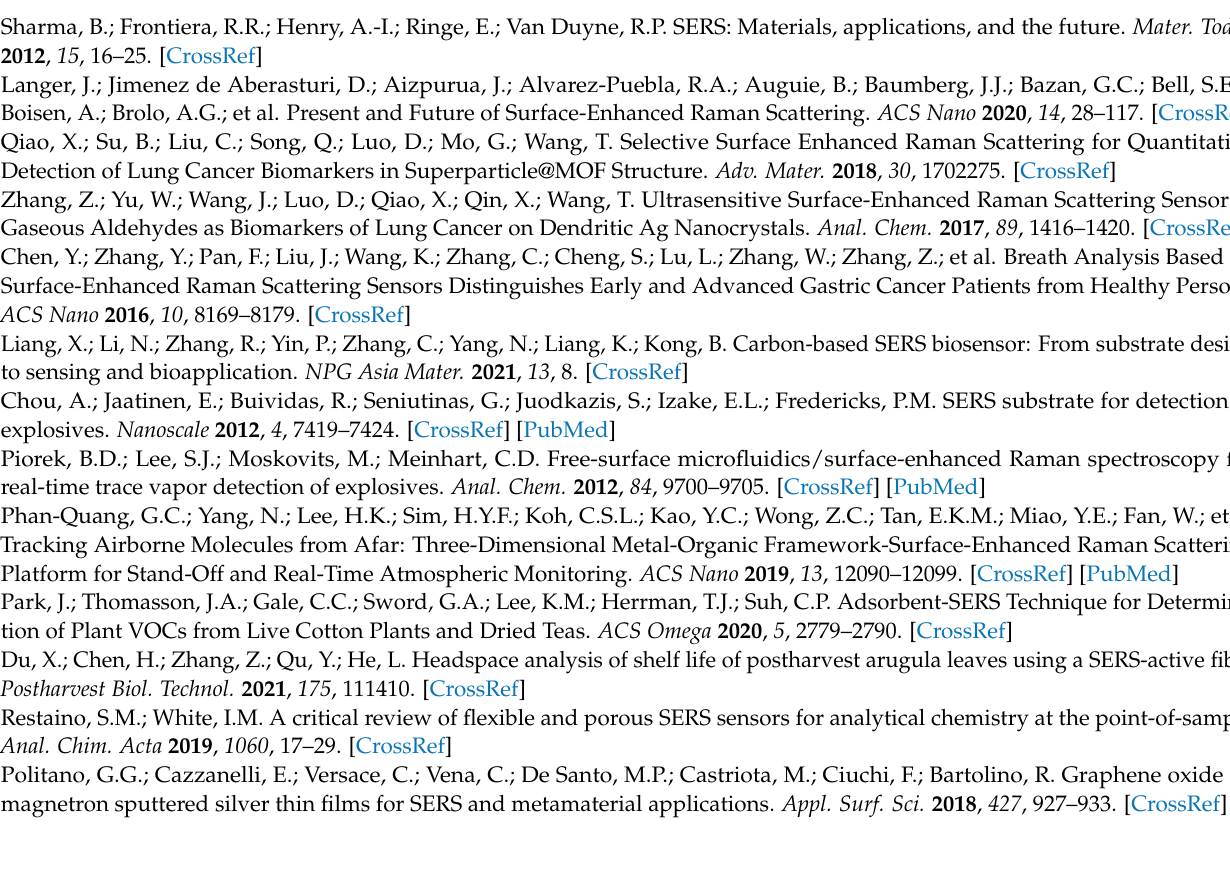
spectra of phenethyl alcohol gas detected by (a) PAA, (b) PMMA and (c) PDMS coated SERS gas sensor, Figure S5: Raman intensity at 1007 cm − 1 of random 30 points obtained by using (a) PAA, (b) PMMA and (c) PDMS coated sensors for acetophenone gas detection, Figure S6: Raman spectra of acetophenone gas detected by (a) PAA, (b) PMMA and (c) PDMS coated sensors, Figure S7: Raman intensity at 1175 cm − 1 of random 30 points obtained by using (a) PAA, (b) PMMA and (c) PDMS coated sensors for anethole gas detection, Figure S8: Raman spectra of anethole gas detected by (a) PAA, (b) PMMA and (c) PDMS coated sensors, Figure S9: PCA score plots of phenethyl alcohol, acetophenone and anethole gases detected by bare SERS substrate, Figure S10: PCA score plots of the (a) two one-layer film coated PMMA, PAA, (b) one two-layer film coated PMMA-PAA SERS sensors for phenethyl alcohol, acetophenone and anethol gases, Figure S11: PCA score plots of the (a) two one-layer film coated PDMS, PMMA, (b) one two-layer film coated PDMS-PMMA SERS sensors for phenethyl alcohol, acetophenone and anethol